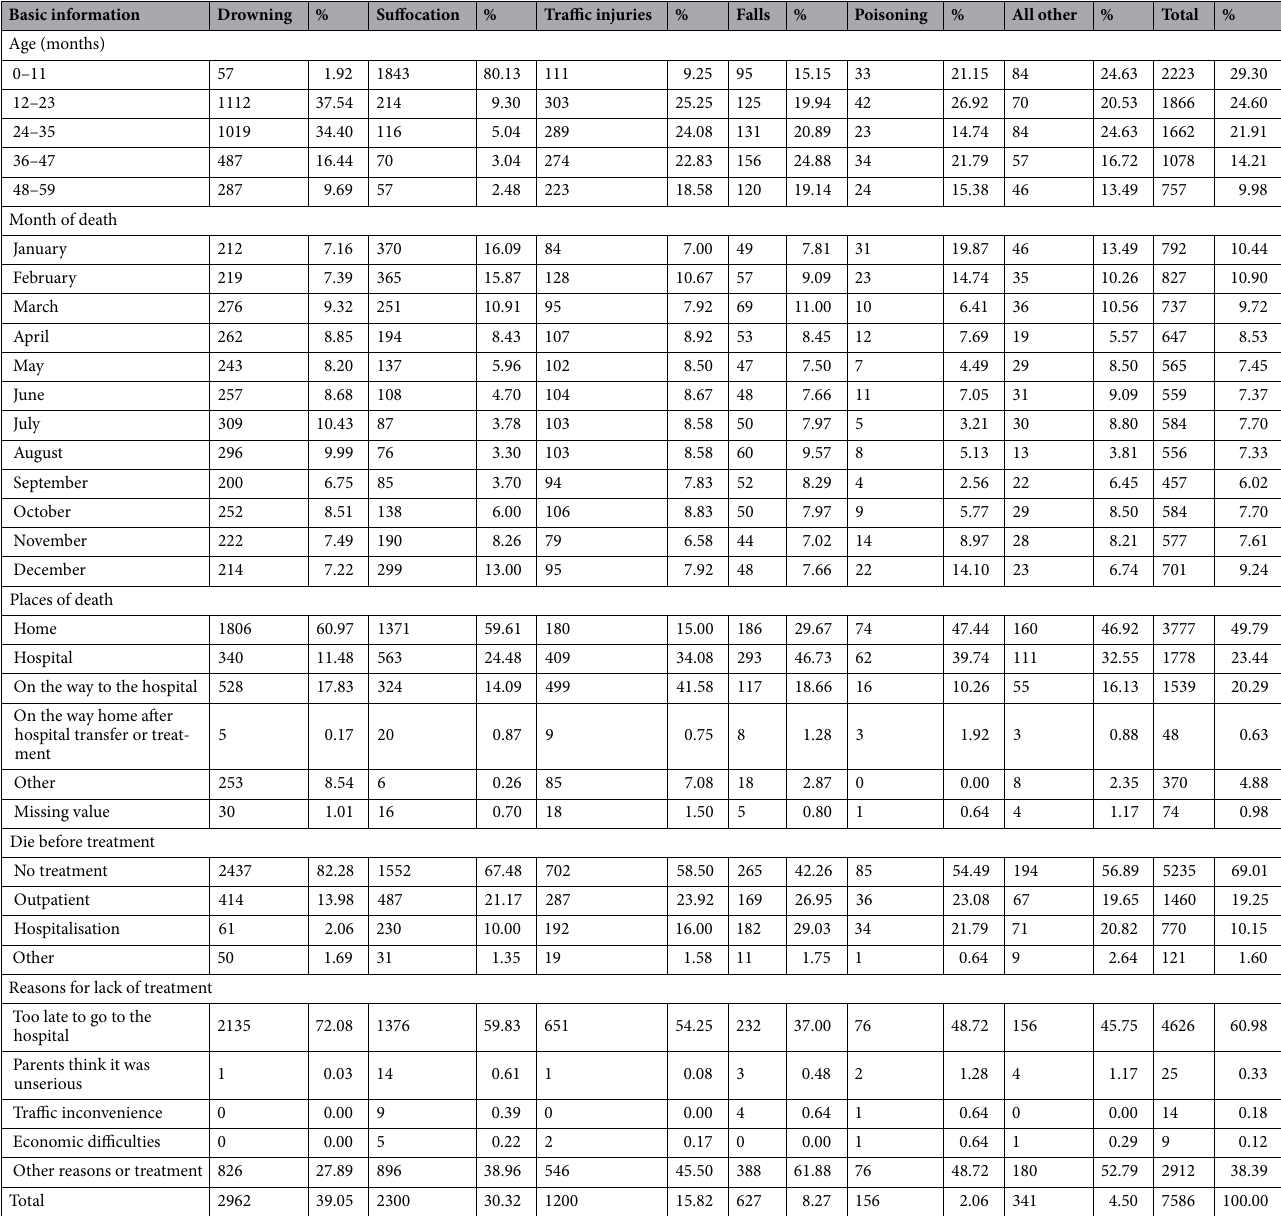
Table 7. Proportions of injury-related under-five deaths by injury types and epidemiological